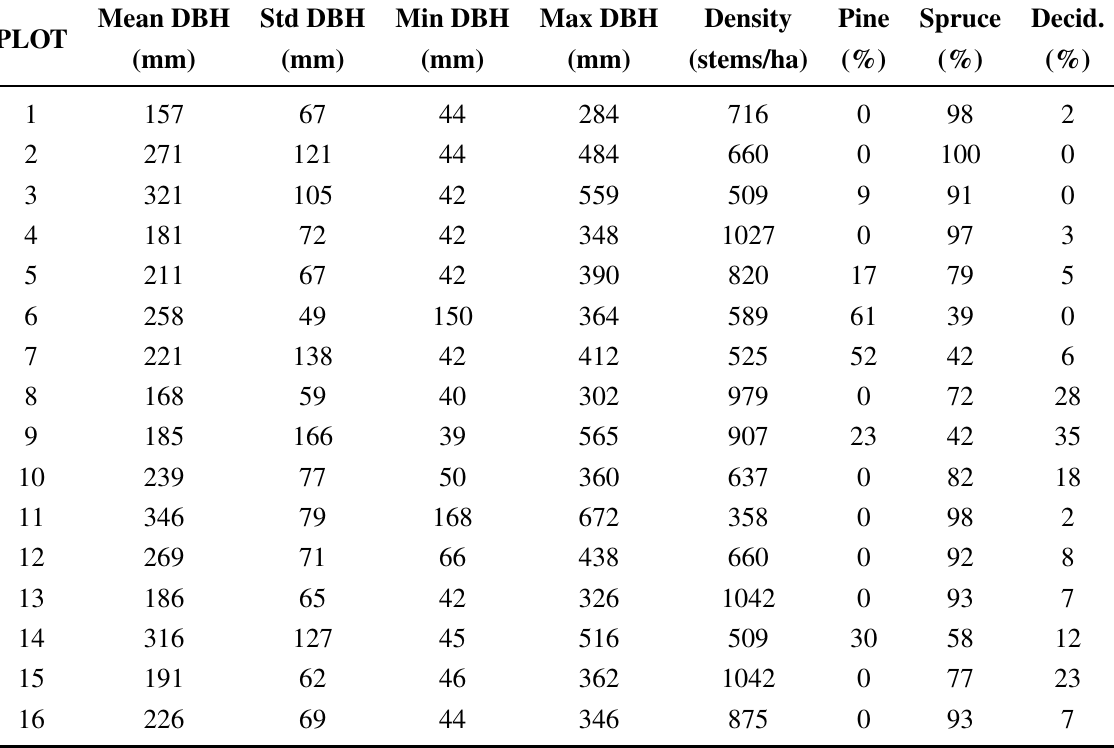
Table 1. Descriptive statistics of the diameter at breast height (DBH) for the evaluation plots.